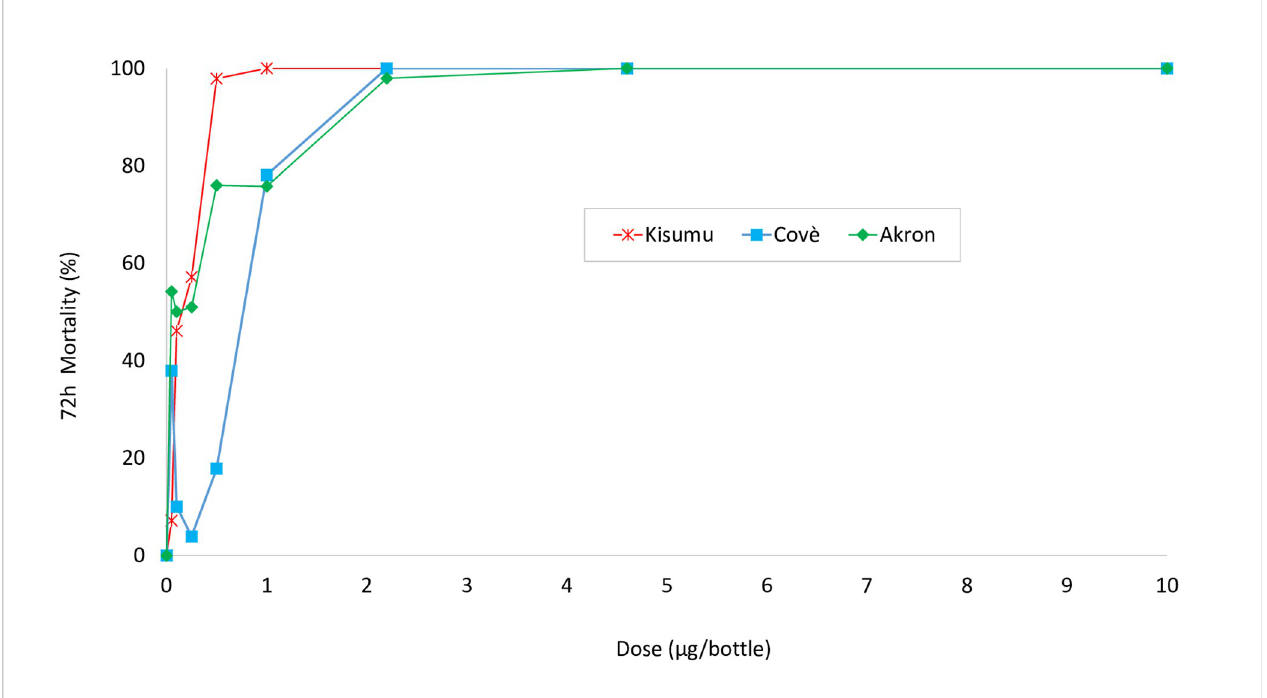
Fig 3. Mortality rates (72h) in broflanilide dose response bottle bioassays with 800 ppm of Mero 1 with An . gambiae s.s. Kisumu, An . gambiae s.l. Cov è , and An . coluzzii Akron strains.